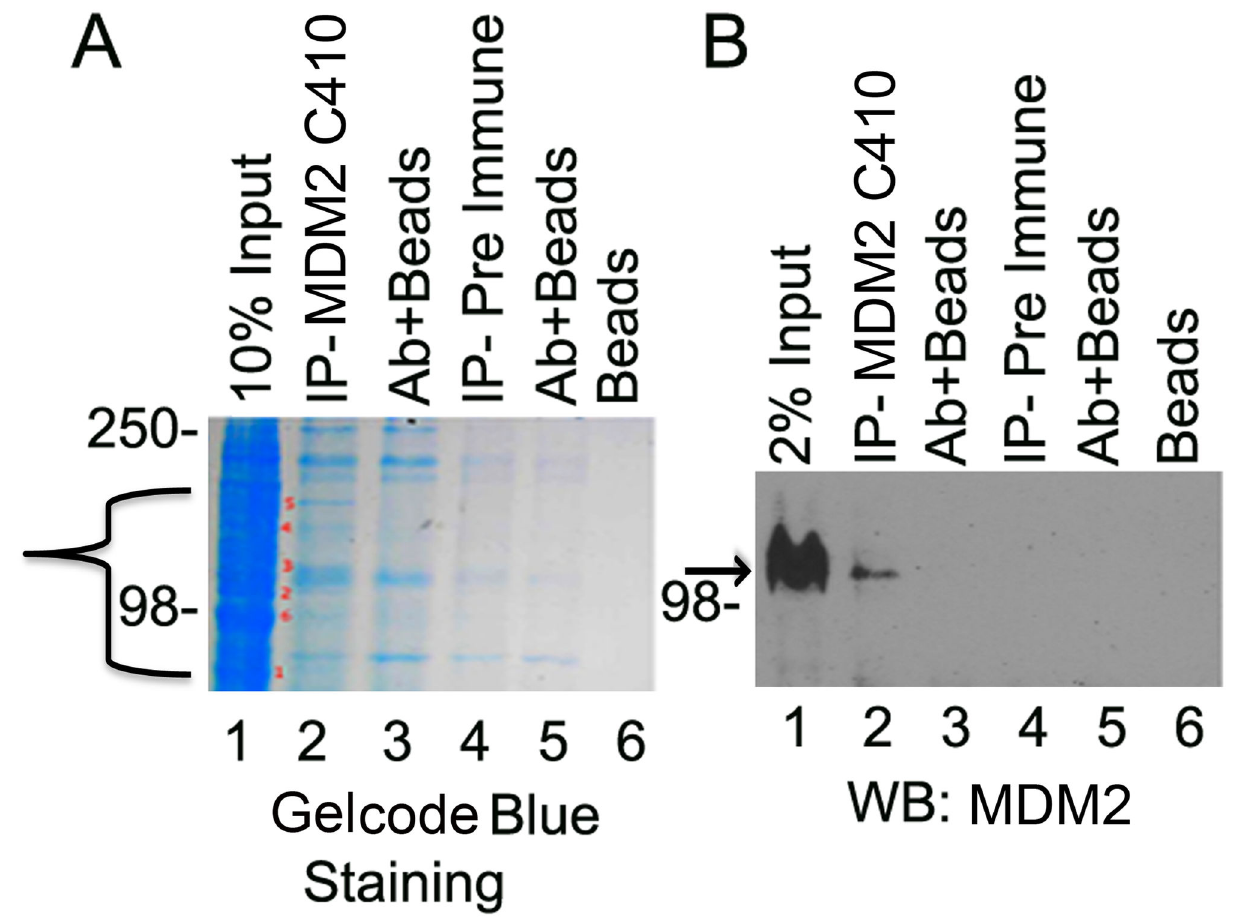
Figure 7. Human MDM2-C interacts with a variety of proteins in vivo . Immunoprecipitation from MANCA whole cell extracts using MDM2 C410 and pre-immune polyclonal serum antibodies antibodies. Samples were electrophoresed onto a 10% SDS-PAGE gel in duplicate. A . One half was stained with coomassie blue for protein detection and protein bands from A were excised for analysis via LC/MS/MS. B . Samples from half of gel A were transferred to nitrocellulose membrane and MDM2 protein was detected using the MDM2 monoclonal antibody mix (4B2, 2A9, 4B11). A . Bracket represents region where bands were cut out for LC/MS/MS analysis. B . Arrows depict MDM2-C protein. doi: